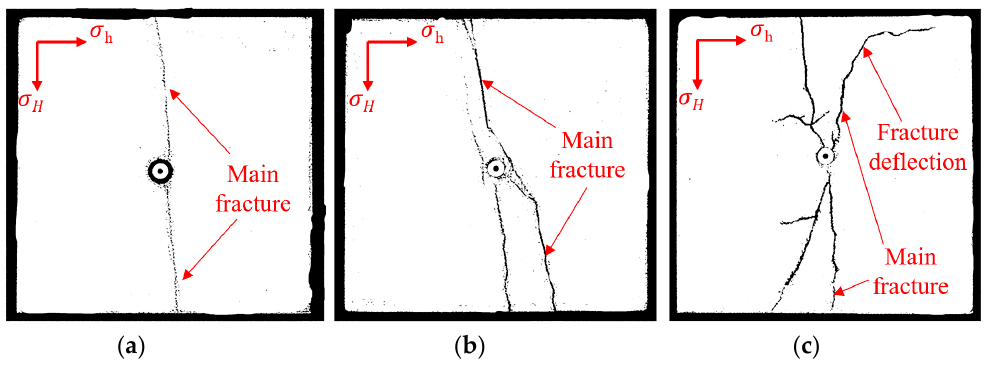
Figure 4. CT scanning images with various fluid under the same stress state. ( a ) water; ( b ) liquid carbon dioxide; ( c ) supercritical carbon dioxide. Supercritical carbon dioxide creates fractures with a complex fracture pattern, which includes fractures and secondary